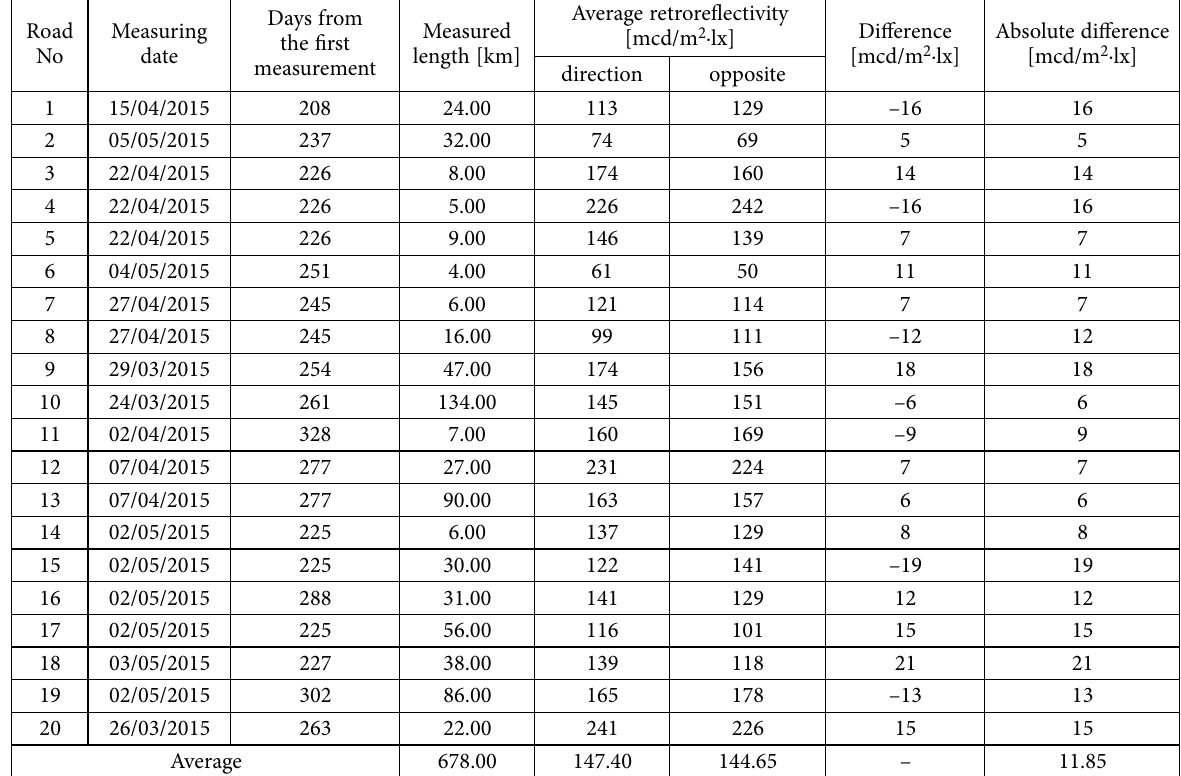
Table 2. Results of retroreflectivity measurement in the direction of application and the opposite direction for existing paint markings